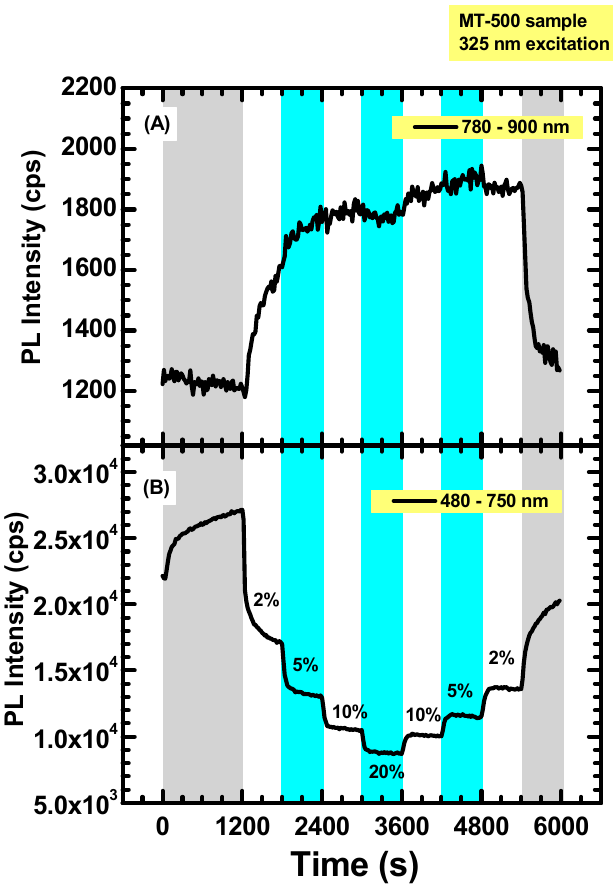
Figure 9. Time dynamics of MT-500 PL intensity integrated over the wavelength intervals 780–900 nm ( A ) and 480–750 nm ( B ) as the sample is exposed to variable concentrations of dry air: The highlighted gray regions indicate exposure to pure nitrogen. The air percentages are indicated in figure.